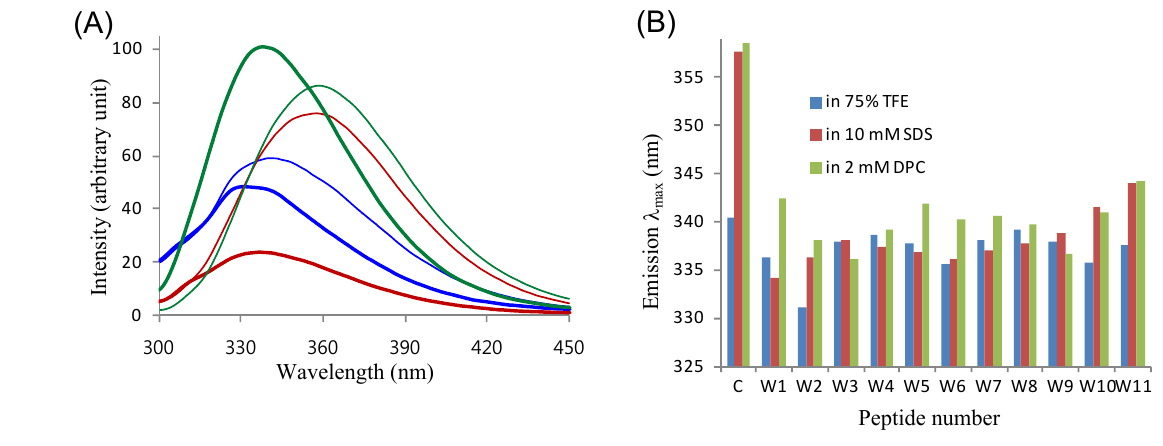
K W n model 5 5